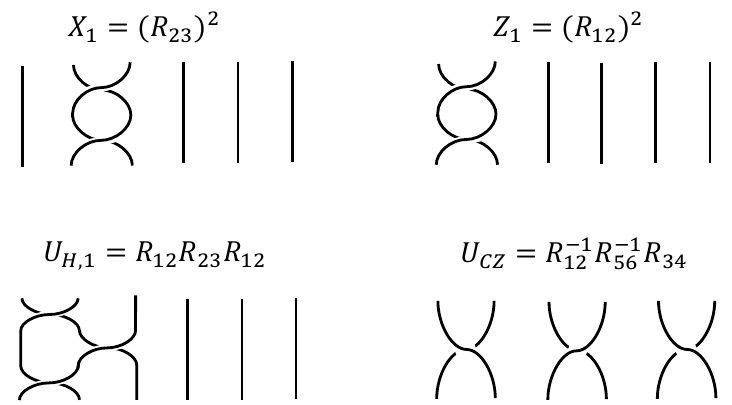
Figure 8: The elementary braids corresponding to the X -, Z - and Hadamard U first qubit as well as the controlled- Z gate U qubit are given by (24) and